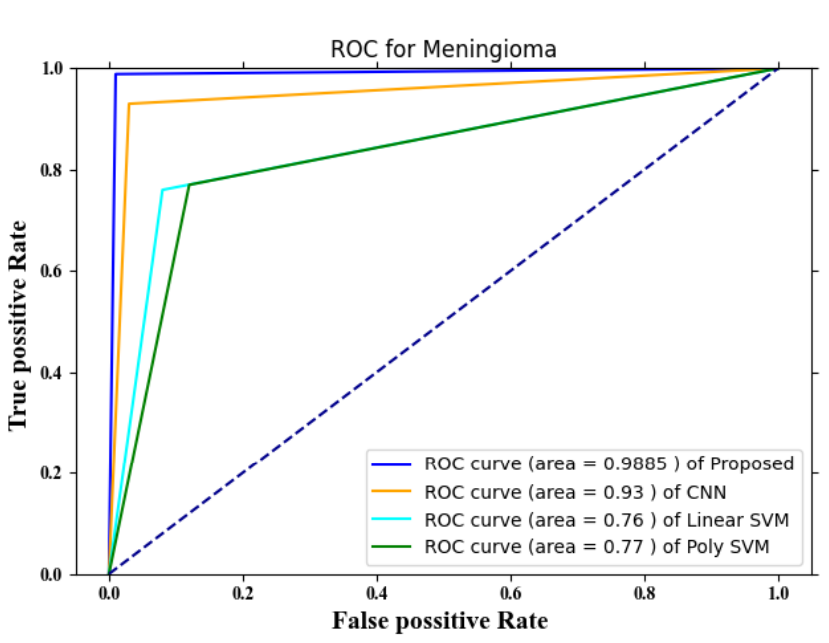
Figure 5. ROC for glioma tumors.